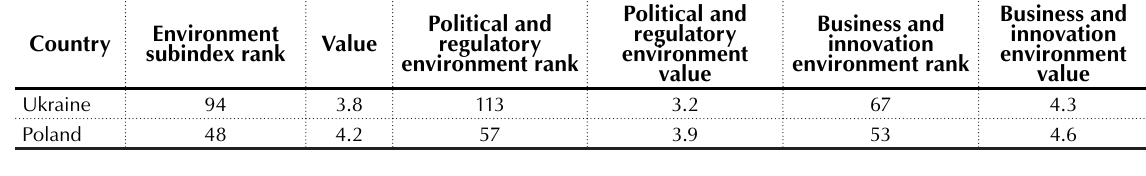
Table 7. Readiness sub-index and pillars for Ukraine and Poland Readiness Country